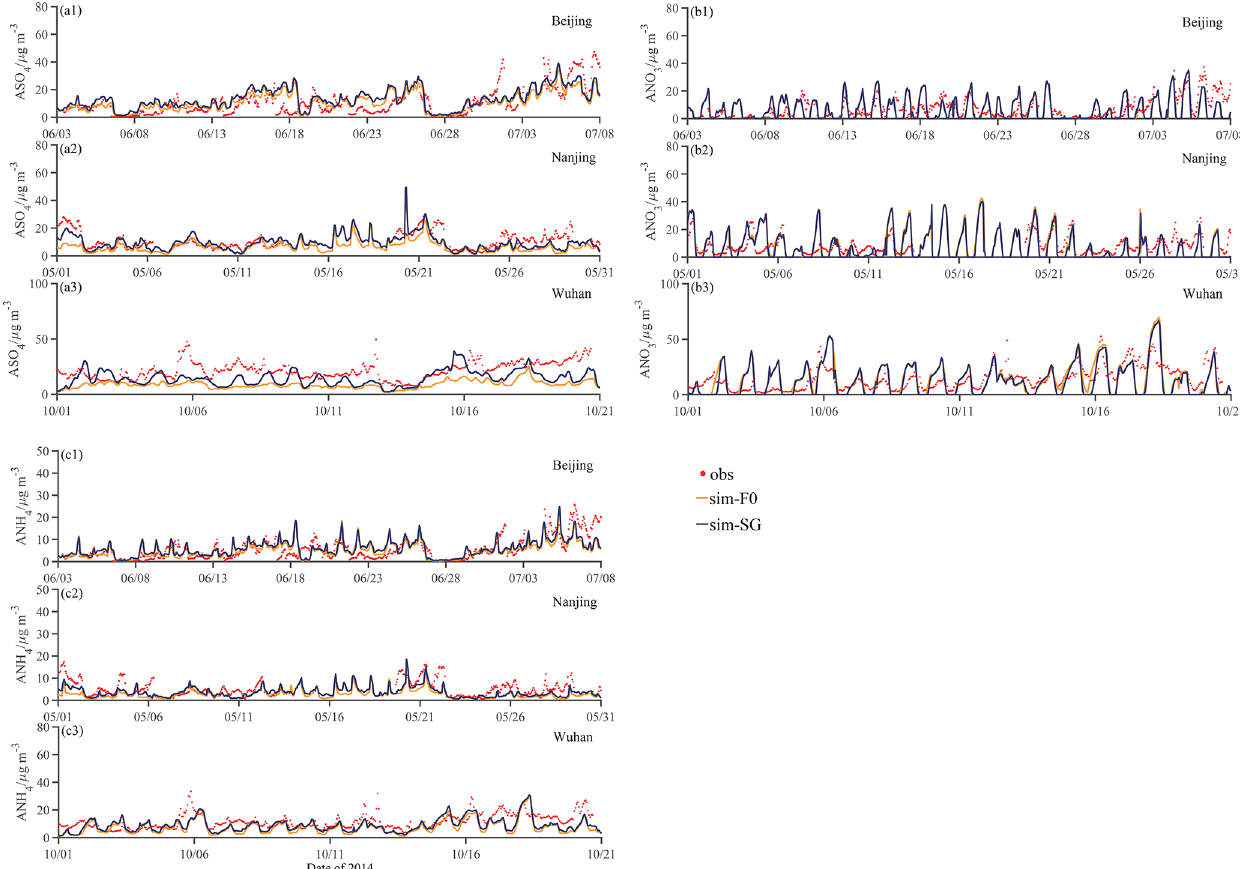
Figure 5. Comparison of hourly simulated aerosol components against site observations in Beijing, Nanjing and Wuhan in warm seasons: (a1–a3) sulfate, (b1–b3) nitrate, (c1–c3) ammonium. The blue and orange lines represent simulations with the SG scheme and with constant f ox of 0% (F0), respectively. The red dots represent observations.